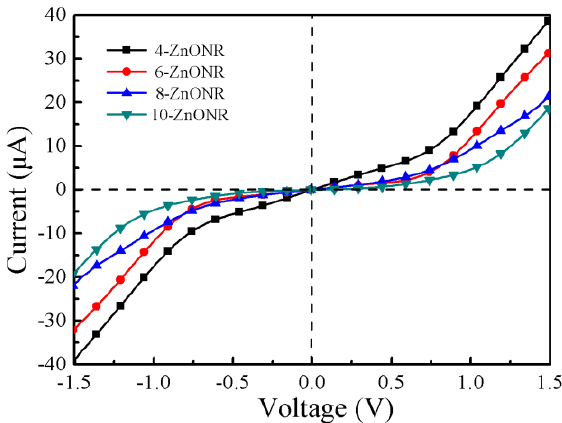
Figure 5. Current–voltage (I–V) curves of the n -ZnONR ( n = 4, 6, 8, 10) devices.